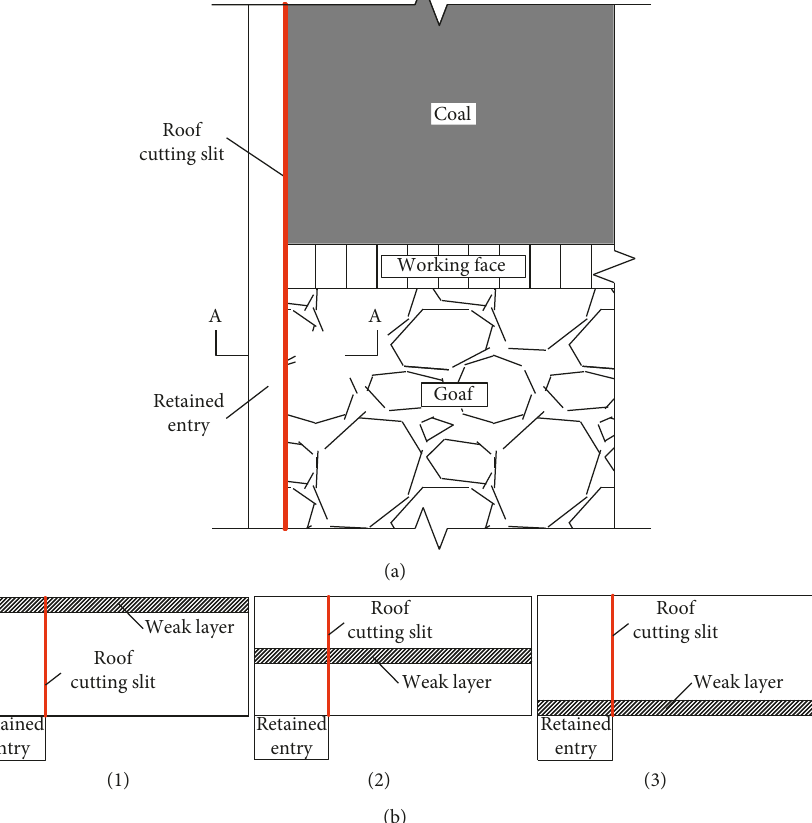
Figure 3: Schematic diagram of roof cutting with different composite roof structures: (a) layout of roof cutting entry retaining and (b) inclination section of retained entry: (1) weak layer in upper, (2) weak layer in middle, and (3) weak layer in